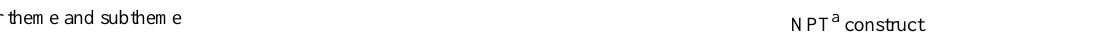
Table 7. Mapping of themes onto normalization process theory constructs. Major theme 1: Lack of discussion between HCPs b and people with T2DM c about DSME d at the time of